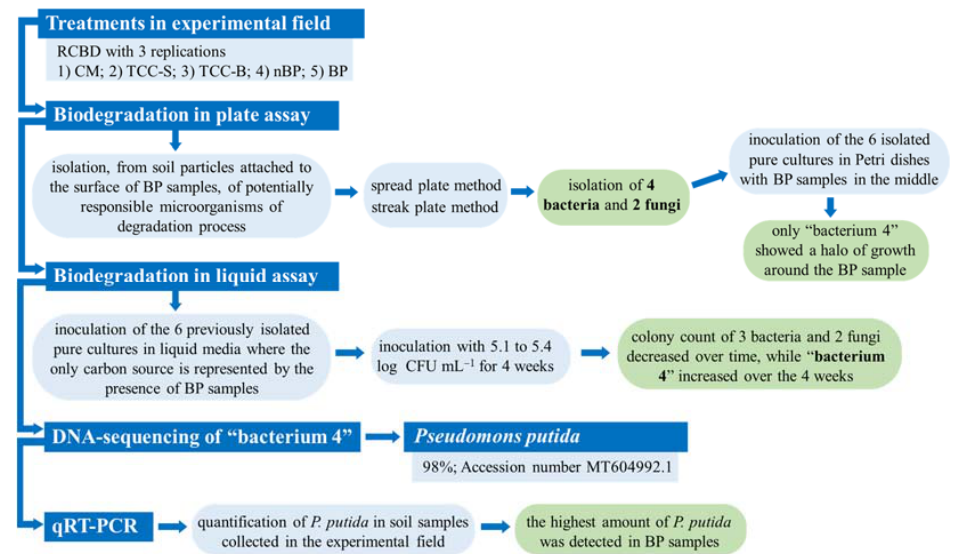
Figure 1. Graphical scheme of the experimental activities. RCBD, randomized complete block design; CM, conventional apricot management; TCC-S, Trifolium subterraneum L. cover cropping leaving dead mulch on the soil surface; TCC-B, T. subterraneum cover cropping burying dead mulch in the soil; nBP, no ‐ biodegradable plastic; BP, biodegradable plastic.